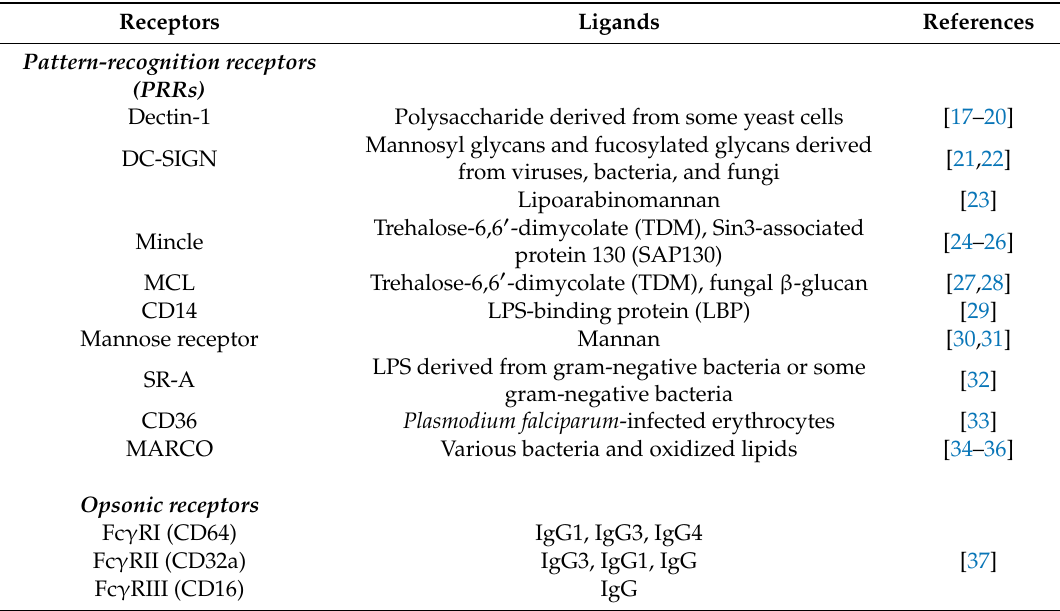
Table 1. Phagocytic receptors and their